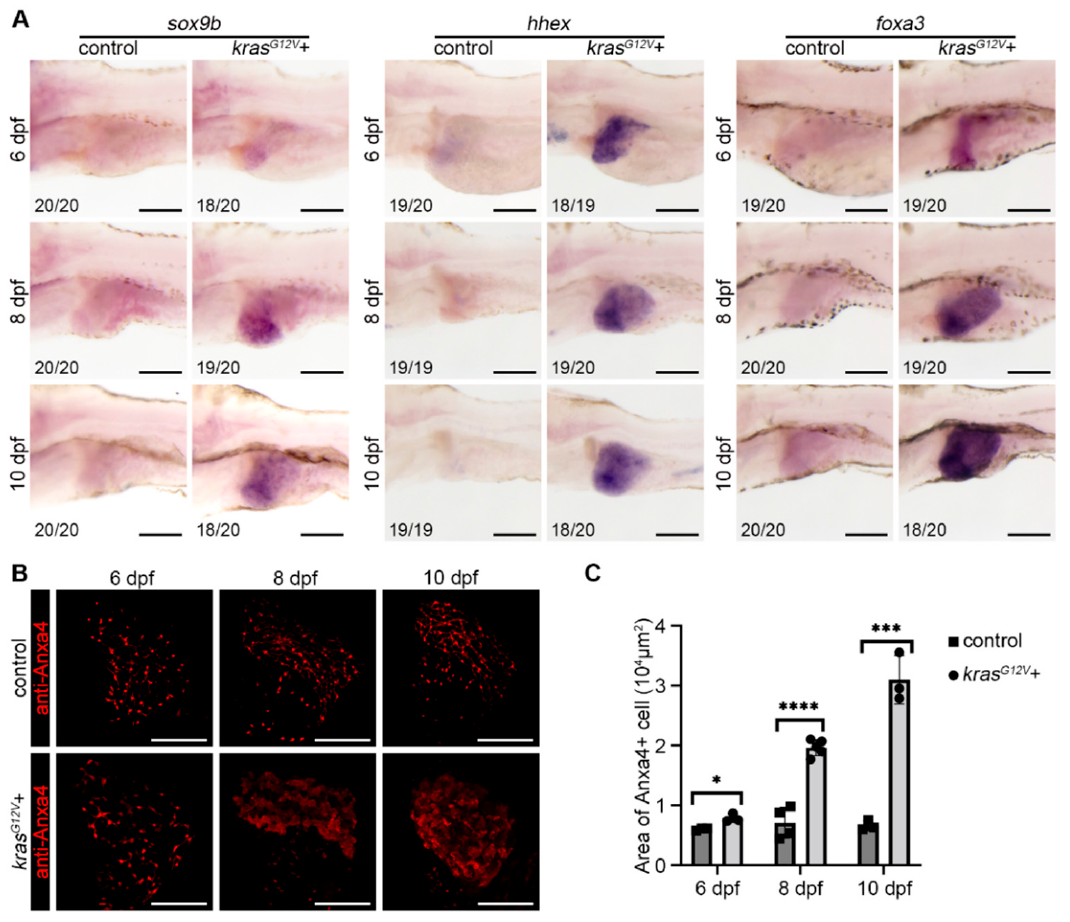
Figure 2. Zebrafish hepatocytes undergo dedifferentiation and biliary duct activation after kras G12V induction. ( A ) Whole-mount in situ hybridization (WISH) results showed the expression pattern of sox9b , hhex , and foxa3 at 6 dpf, 8 dpf, and 10 dpf, respectively, after DOX activation of kras G12V . ( B , C ) Antibody staining of biliary duct marker Anxa4 in zebrafish liver expression at 6 dpf, 8 dpf, and 10 dpf after DOX induction, and statistics of Anxa4+ area in the liver in the control ( n = 10) and kras G12V + ( n = 11) groups. Numbers indicate the percentage of larvae exhibiting this expression. Asterisks show significance: *— p < 0.05; ***— p < 0.001; ****— p < 0.0001. Scale bars—100 μ m; error bars—S.D.